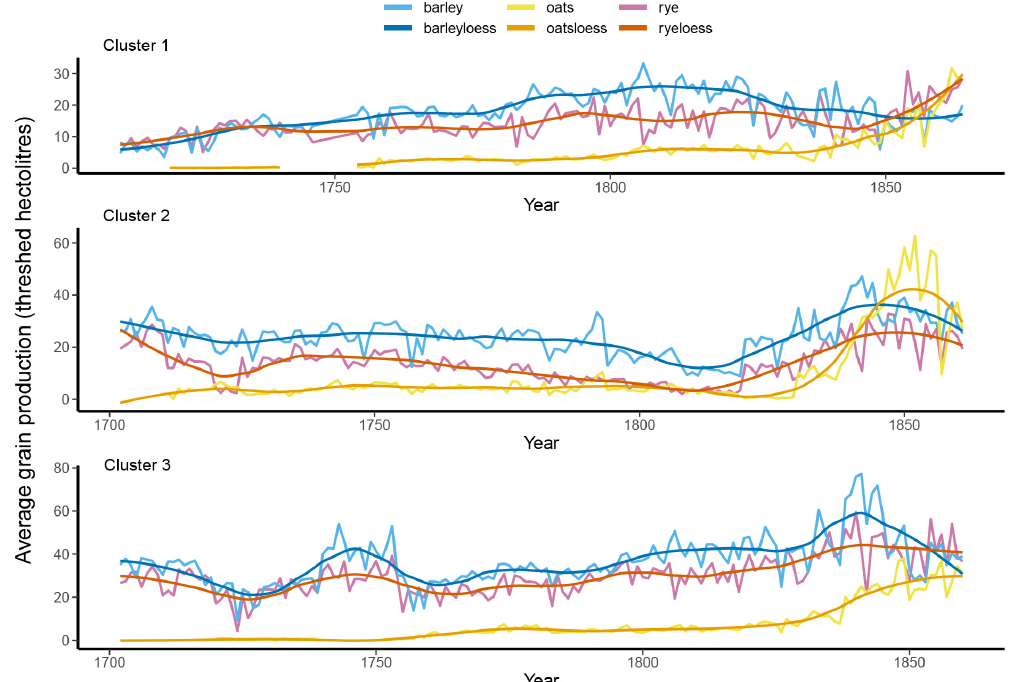
Figure 5. Average grain production (threshed hectoliters) in each cluster over time, including estimated loess. For cluster 1 the years 1743– 1746 are covered by only one farm, heavily skewing the average for those years. Therefore, I have substituted the values for rye and barley for the years 1743–1746 with values obtained from a linear estimation of the relationship between the production of that farm and the average production in the cluster in the years 1727–1742. Source: